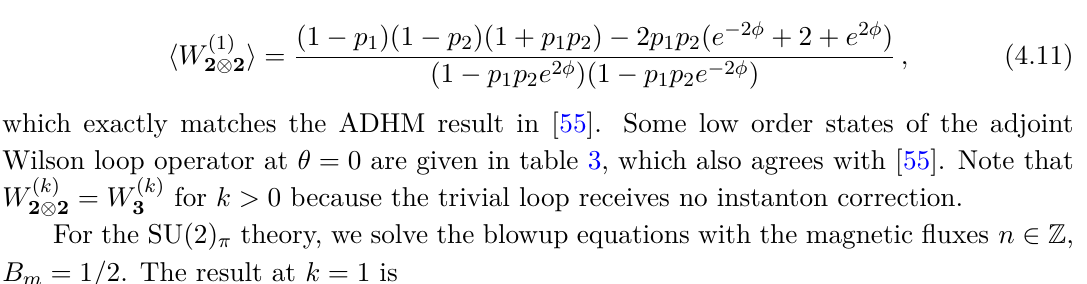
= 0 and solve the blowup m